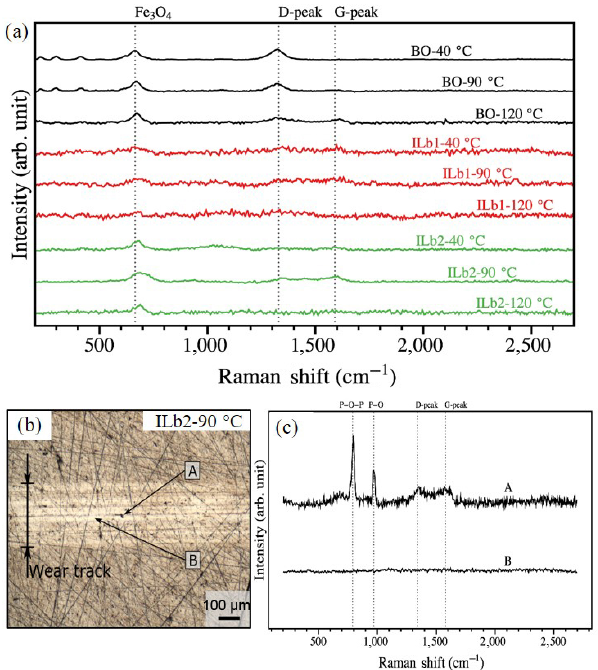
Fig. 8 (a) Raman spectra of the wear tracks after SRV testing with BO, ILb1, and ILb2 under three different operating temperatures, (b) optical micrograph of the wear track of ILb2 at 90 °C after the SRV test, and (c) Raman spectra of Positions A and B on the wear